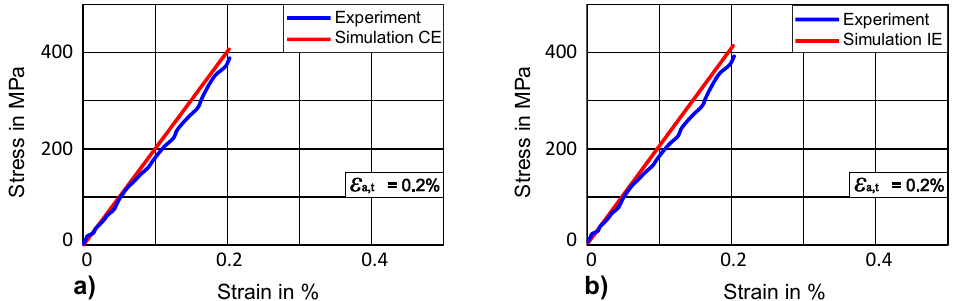
Figure 9. Comparison of stress-strain curve for elastic range ( a ) with crystal elasticity (CE) ( b ) with isotropic elasticity (IE). Materials 2019 , 12 , x FOR PEER REVIEW